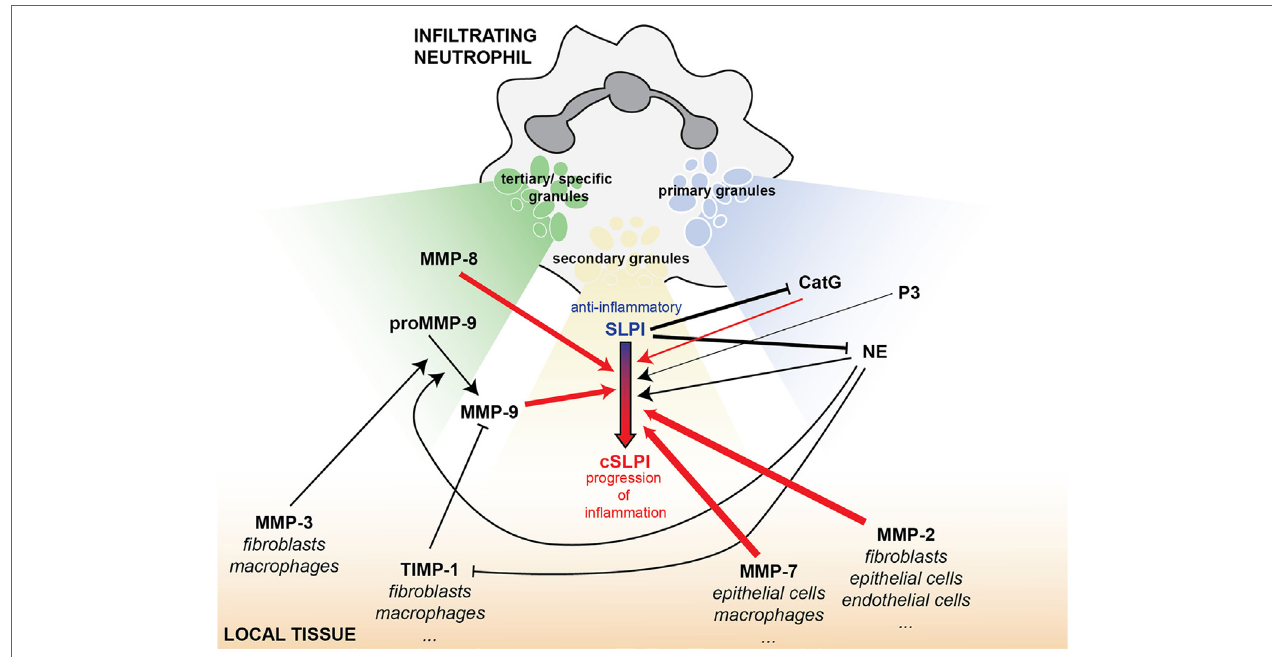
FigUre 7 | SLPI as an element of the interconnected protease network, bridging MMPs and serine proteases in inflammation. Infiltrating neutrophils carry a battery of proteolytic or bactericidal proteins ready for release upon an inflammatory insult. Besides local mucosal SLPI production, SLPI is also found in the secondary granules of neutrophils (yellow). MMP-9 and MMP-8 are stored in tertiary or specific granules (green) and the serine proteases cathepsin G (CatG), proteinase 3 (P3), and NE in primary granules (blue). Depending on the magnitude of the inflammatory stimulus, tertiary granules are released first, followed by secondary granules and primary granules. This overview shows the interconnectivity between proteases and protease inhibitors released from these vesicles and present in the local tissues (orange). Arrows indicate a positive/stimulatory effect, while solid lines with blunt ends correspond to inhibitory reactions. Line thickness is relative to the efficiency of the inhibitory/stimulatory effect. Red arrows indicate newly described links within this